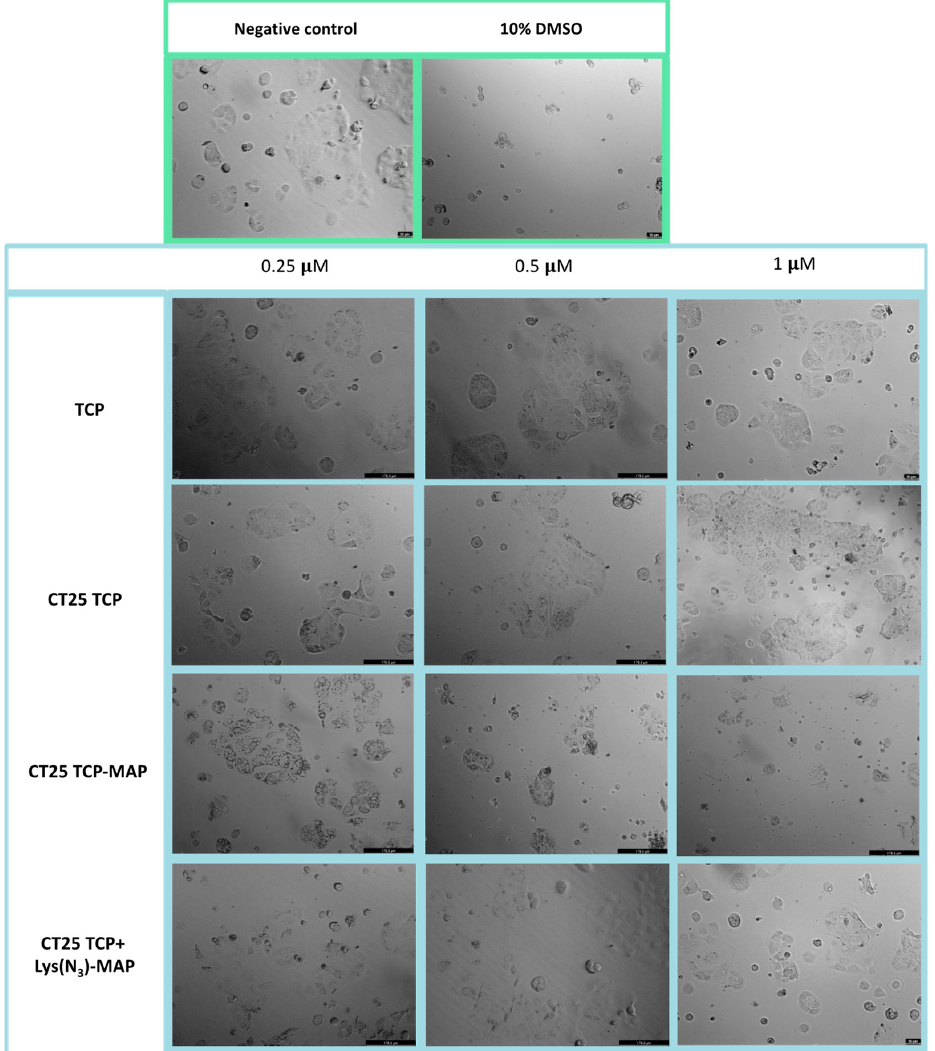
Figure 4. Microscope cellular visualization through Leica DFC350 FX of treatment with negative control (ultra ‐ purified H 2 O), positive control (10% DMSO), free drug, and NLC ‐ loaded formulations (CT25TCP, CT25TCP ‐ MAP and CT25 TCP + Lys(N 3 ) ‐ MAP) on Caco ‐ 2 cell line at concentrations of 0.25, 0.5, and 1 μ M.